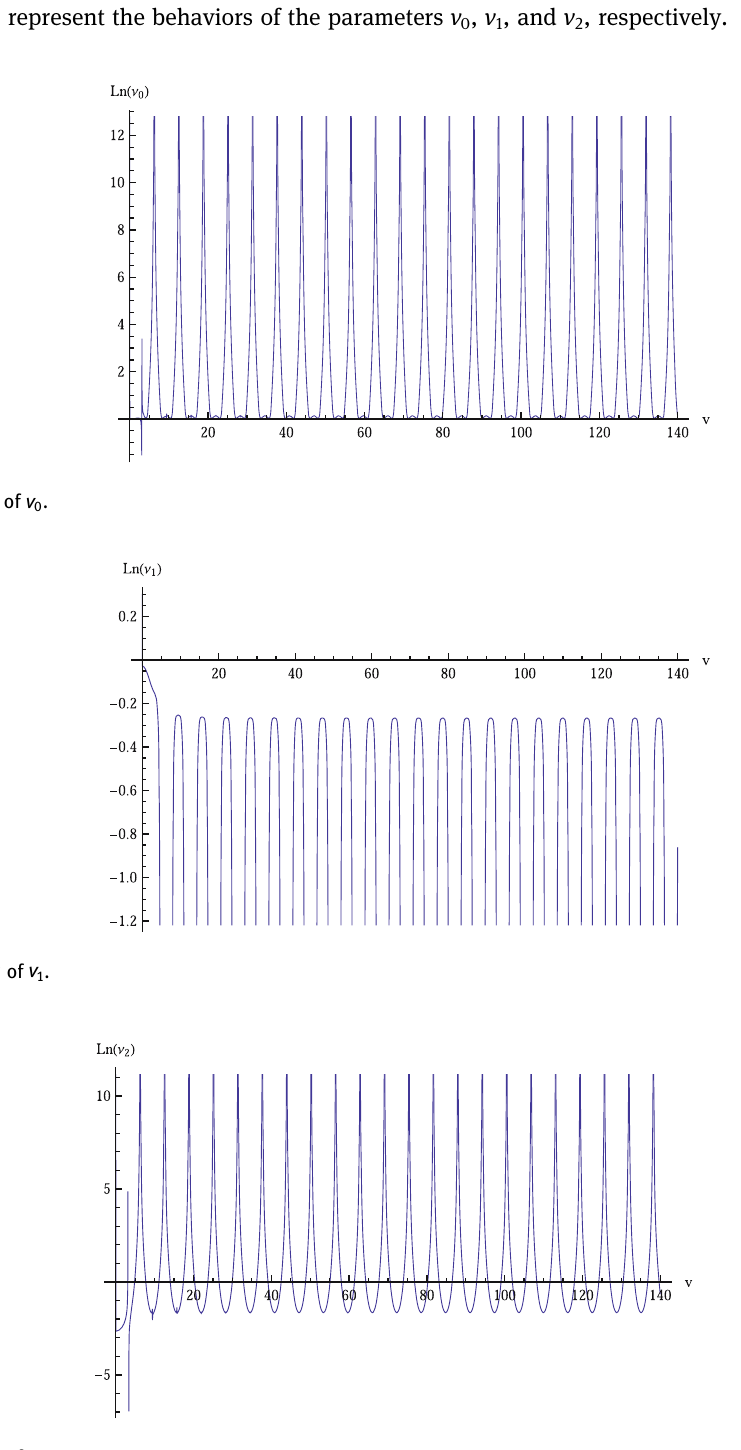
Figure 3: Behavior of ν 2